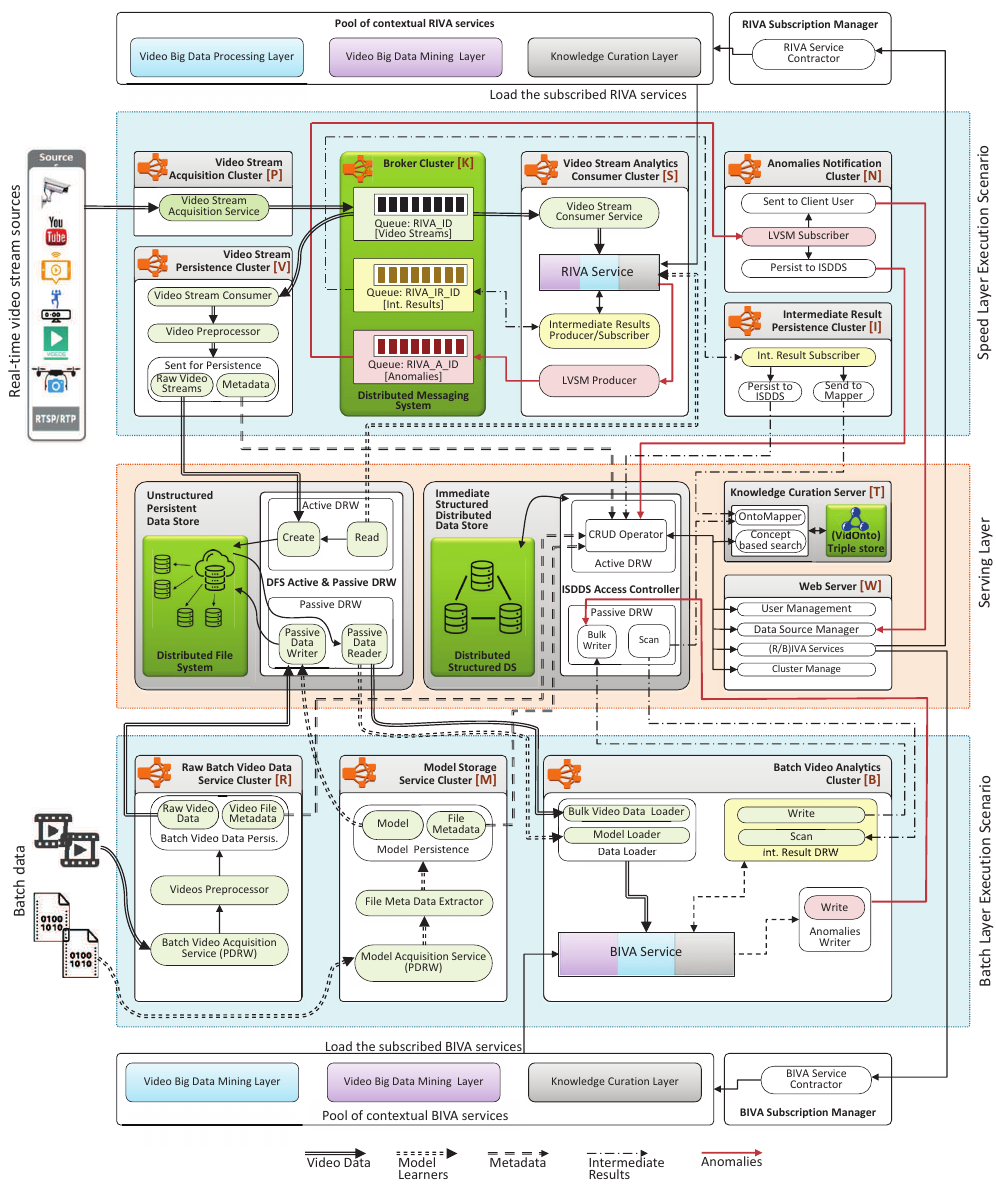
Figure 12. TORNADO execution